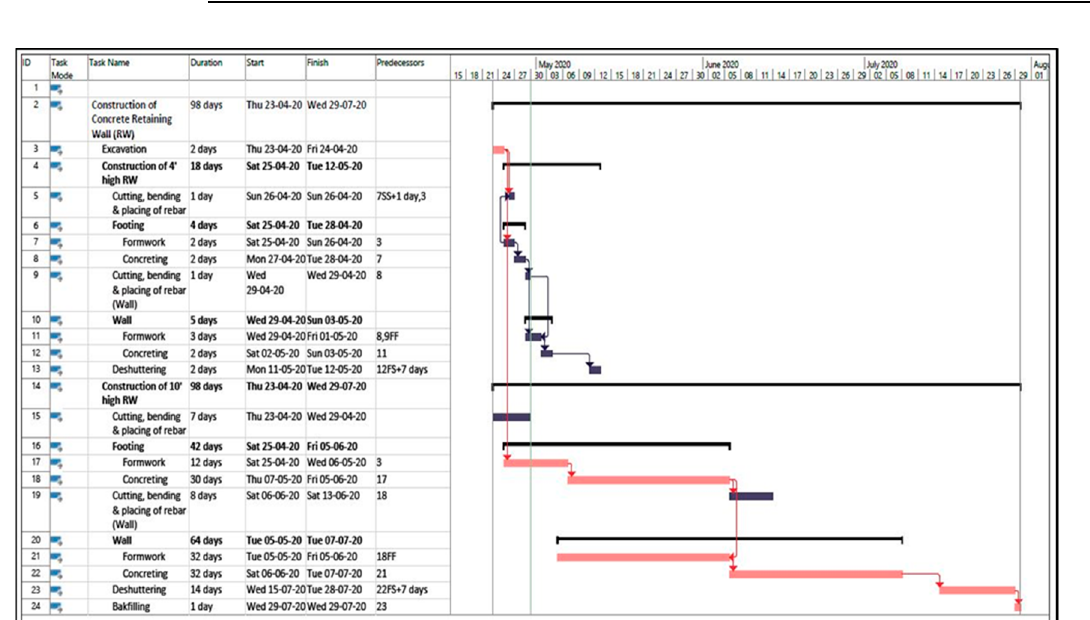
Figure A2. Sample schedule: the concrete wall alternative. Table A2. The estimated costs for the construction of the retaining wall alternatives.